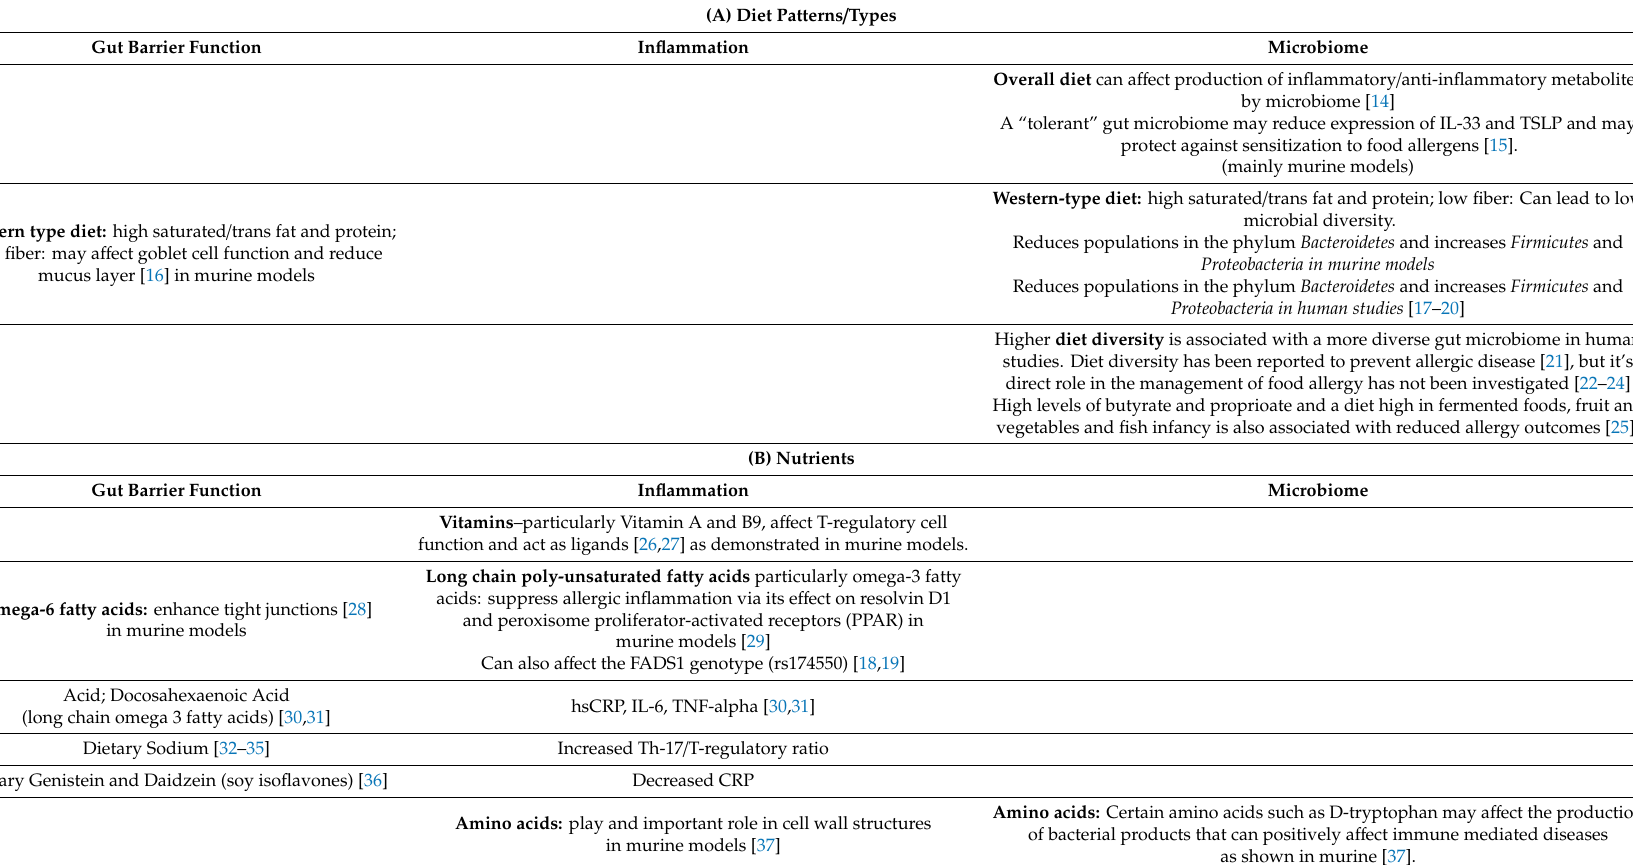
Table 1. Impact of diet patterns / types (A), nutrients (B) other nutritional factors (C) and food preparation / production (D) on gut barrier function, inflammation and the